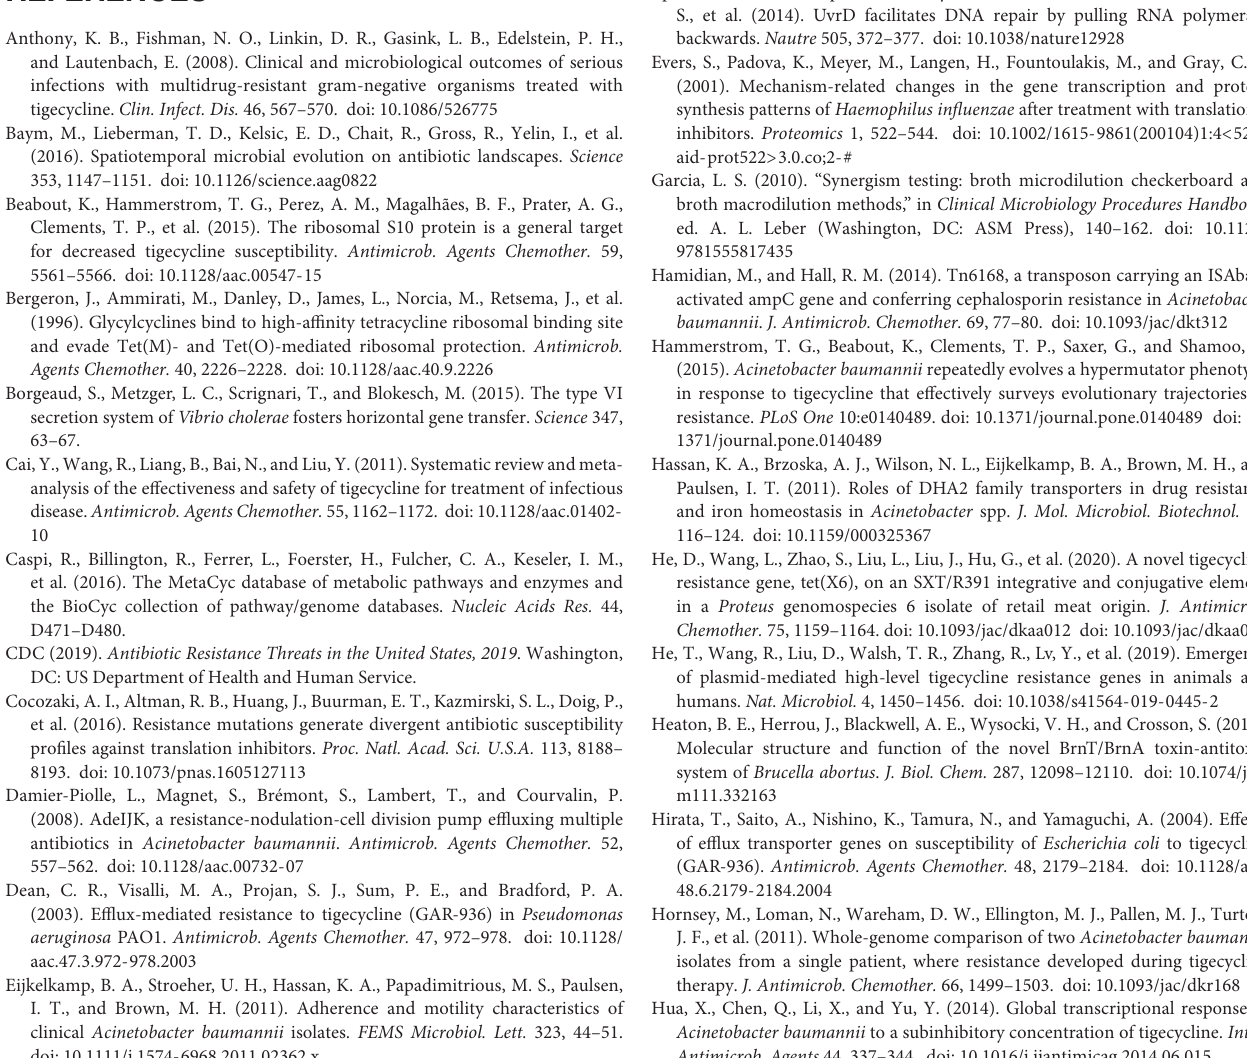
circle 3 shows the degree of differential transcription (increased or decreased) for each gene, and the circle 4 shows the coordinates of the chromosome. The ORFs are color coded according to their respective COG category, and with the color scheme on the right. This map was constructed using a web-based tool Circular Visualization for Microbial Genomes (Overmars et al., 2015). Supplementary Figure 3 | Differential transcription of other membrane transporter encoding genes. Only the differently regulated membrane transporter genes are presented, and their absolute fold changes are more than 1 (log 2 scale) with padj < 0.01. The genes on panels (A) and (B) are color grouped based on the putative substrate specificities. The genes on panel (C) are grouped based on transporter families, as they have no substrate predicted. Full information on gene function annotations is given in supplementary data. Supplementary Figure 4 | Increased transcription of transposase genes and DNA mobilization genes. For each functional group, only differentially transcribed genes with absolute fold changes > 1 (log 2 scale) with padj < 0.01 are shown. The bar charts are grouped by colors according to the biological functions of the genes assigned, with the color scheme on the right. Full information on gene function annotations is given in supplementary